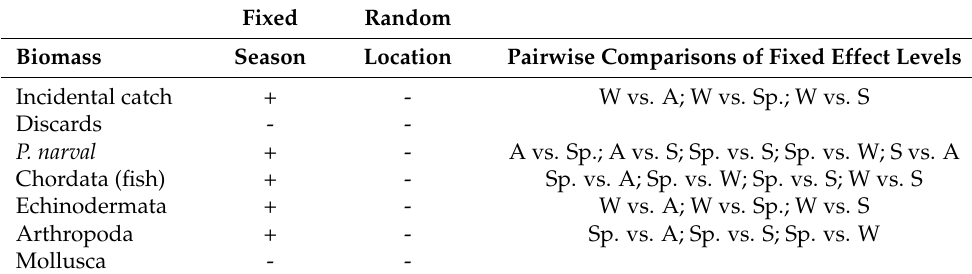
Table 5. Summary of Linear Mixed Model Effects for species biomass with season (fixed factor) and location (random factor) as predictors.